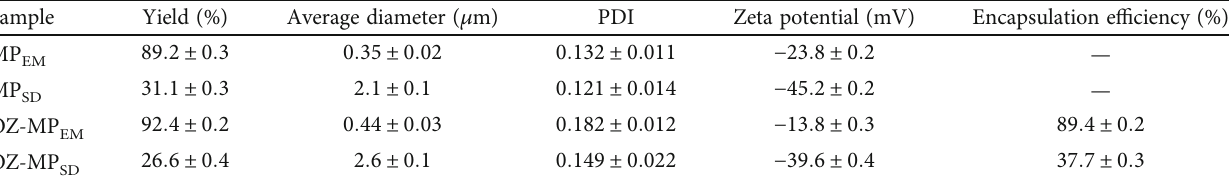
Table 2: Parameters of the obtained